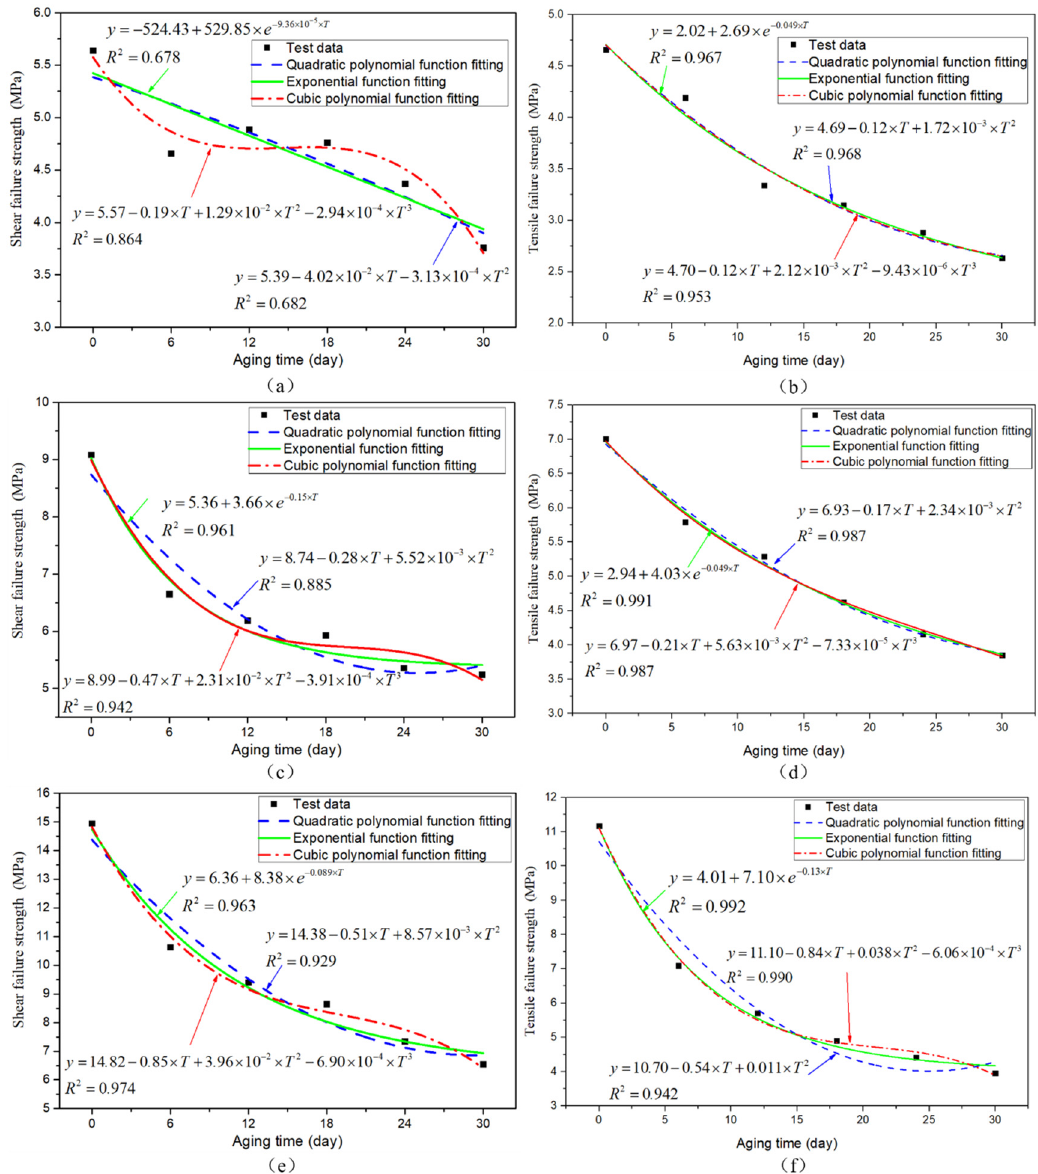
Figure 18. High-temperature test: ( a ) shear failure strength, ( b ) tensile failure strength fitting curve; room-temperature test: ( c ) shear failure strength, ( d ) tensile failure strength fitting curve; low-temperature test: ( e ) shear failure strength, ( f ) tensile failure strength fitting curve.